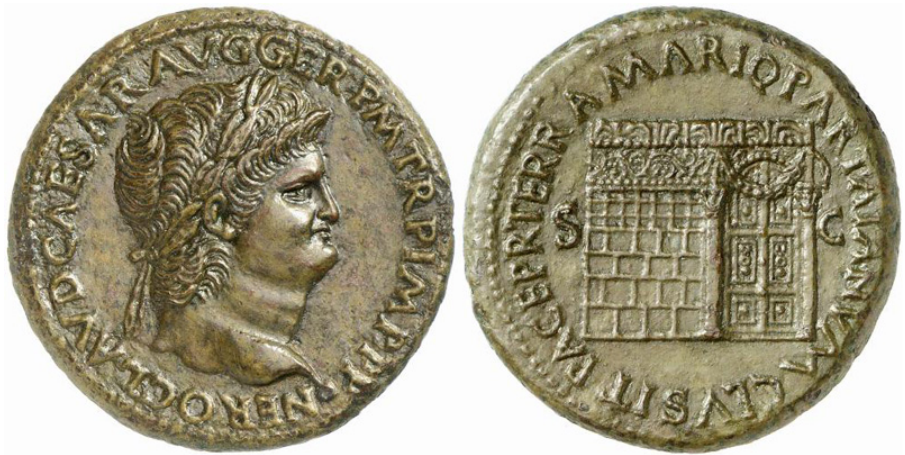
Figure 9. Nero on obverse; shrine of Janus Geminus on reverse of a bronze sestertius. Source: Wikimedia Commons.